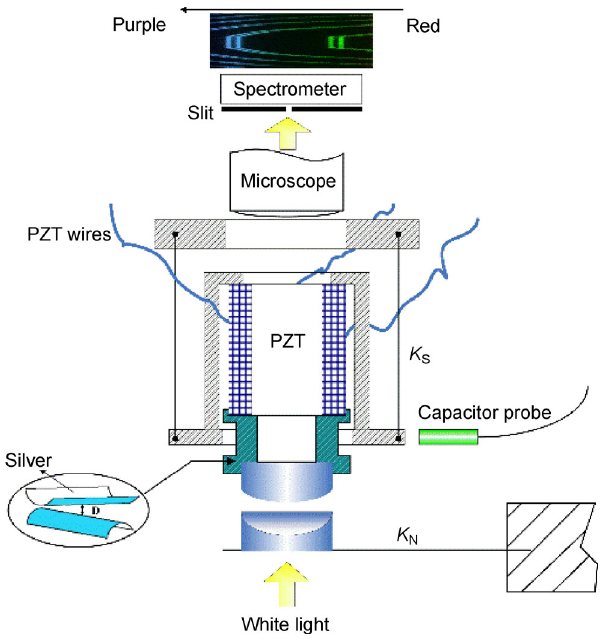
Fig. 4 Sketch of surface force balance developed by Klein et al. [49]. Copyright 1995, the American Association for the Advancement of